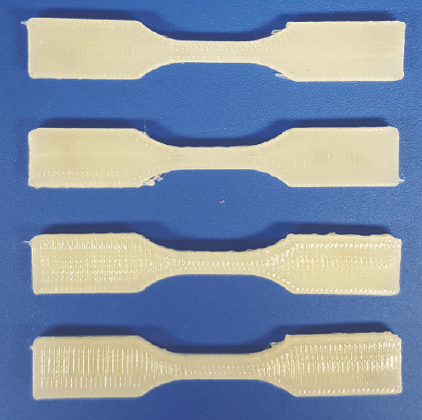
Figure 3: Printed tensile specimens (PLA, phosphate glass 10%).